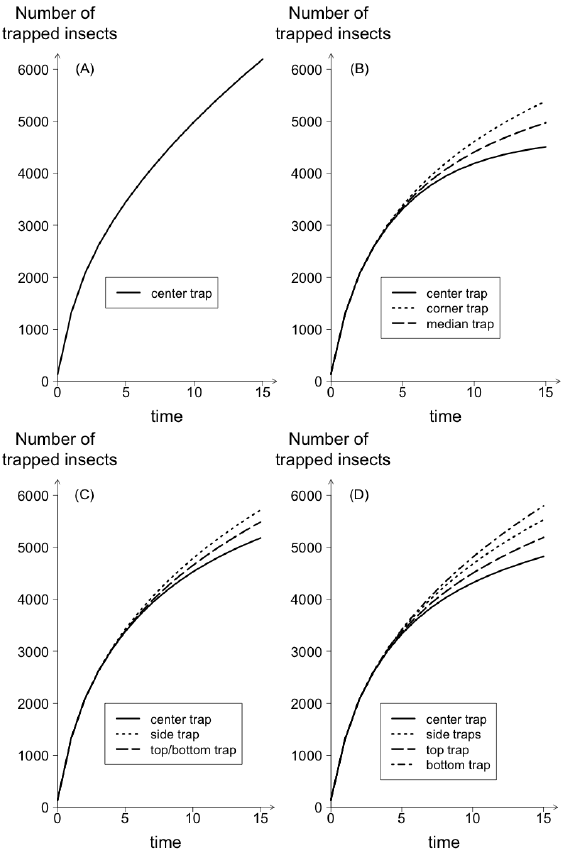
Fig. 5. Cumulative number of captured insects in each trap, using the trap settings (A), (B), (C) and (D) of Fig.